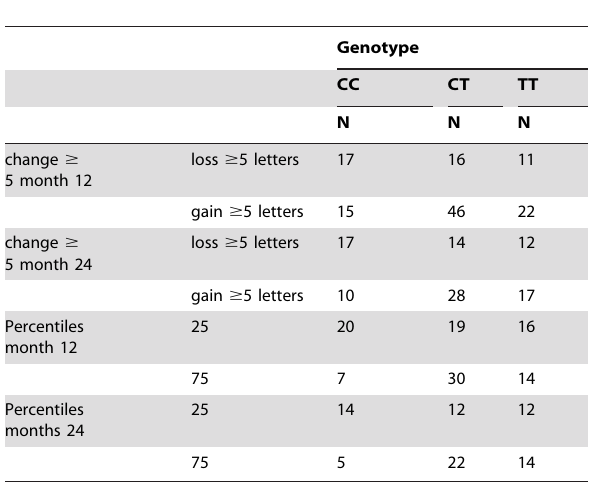
Table 1. Effects of genotype SNP rs1061170 at CFH